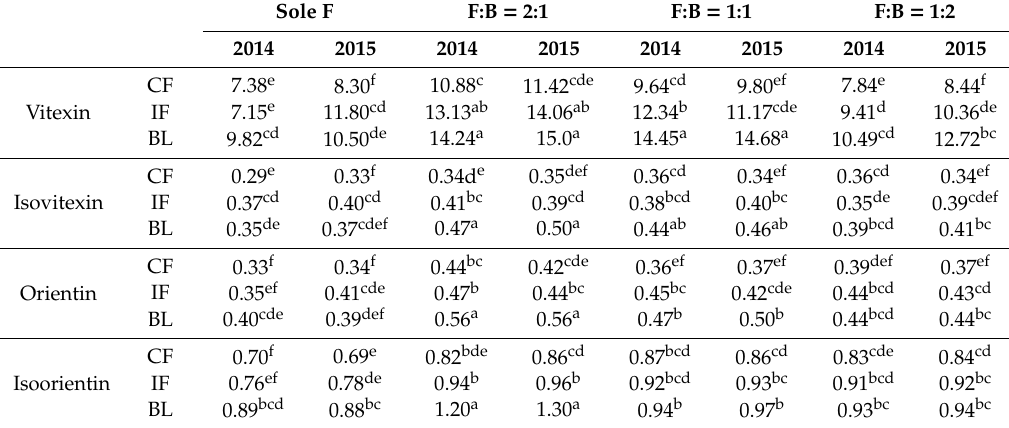
Table 2. Vitexin, isovitexin, orientin, and isoorientin content of fenugreek seeds (mg / g DW) as a ff ected by cropping system × fertilizer types interaction in 2014 and